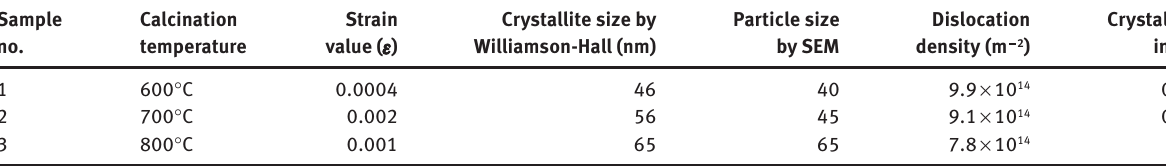
Table 1: Determination of the size of the crystal, strain value, and dislocation density. Sample no.